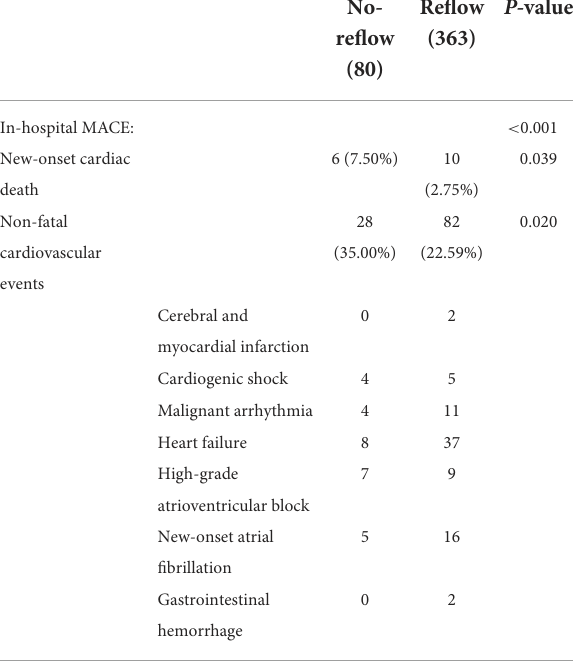
TABLE 3 In-hospital major adverse cardiac events by study